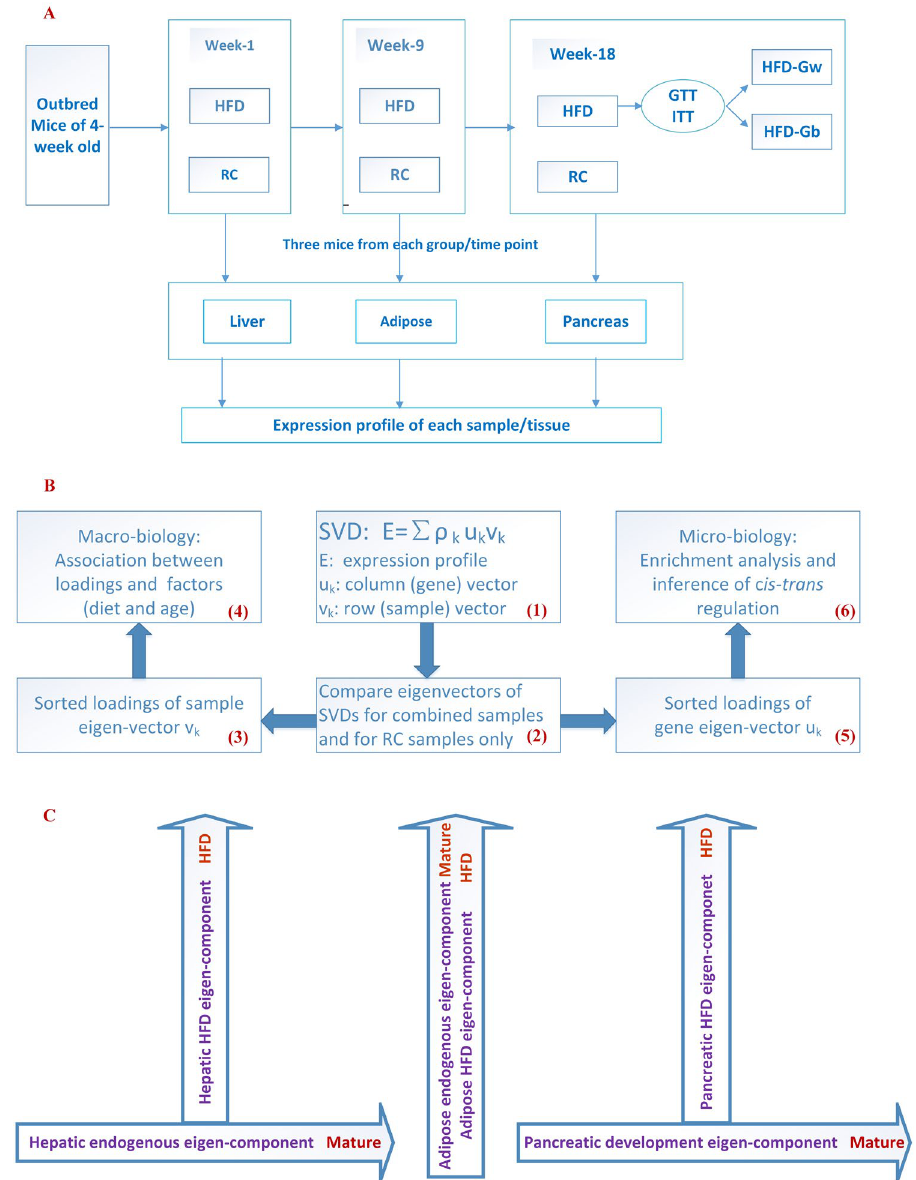
Figure 1. Schemes of the experiment design, dual eigen-analysis and structure of the top eigen-components of the three tissues. ( A ) The outbred mice were fed with RC or HFD. Three mice were randomly selected from each diet group at week 1, 9, and 18. At week 18, the HFD group was further divided into two subgroups, HFD-Gw and HFD-Gb, according to the GTT/ITT results. The expression profiles of their liver, adipose, and pancreas tissues were measured. ( B ) The dual eigen-analysis has several steps. (1) According to the SVD structure, for each tissue, compute the SVD of the expression profile of the HFD and RC samples as well as that for the RC samples only; (2) compare the eigenvectors of the two SVDs and identify the similar and different eigen-components; (3) sort the loadings of each principal sample eigenvector, followed by (4) identifying the associated factor; and (5) sort the loadings of the coupling gene eigenvector, followed by (6) identifying the molecular pathways enriched at its two ends. ( C ) The first and second hepatic eigen-components correspond to the endogenous functional state and the driving impact due to HFD, respectively. Only one meaningful eigen- component was identified for the adipose. The first and second pancreatic eigen-components correspond to the response to the HFD impact and the developmental state